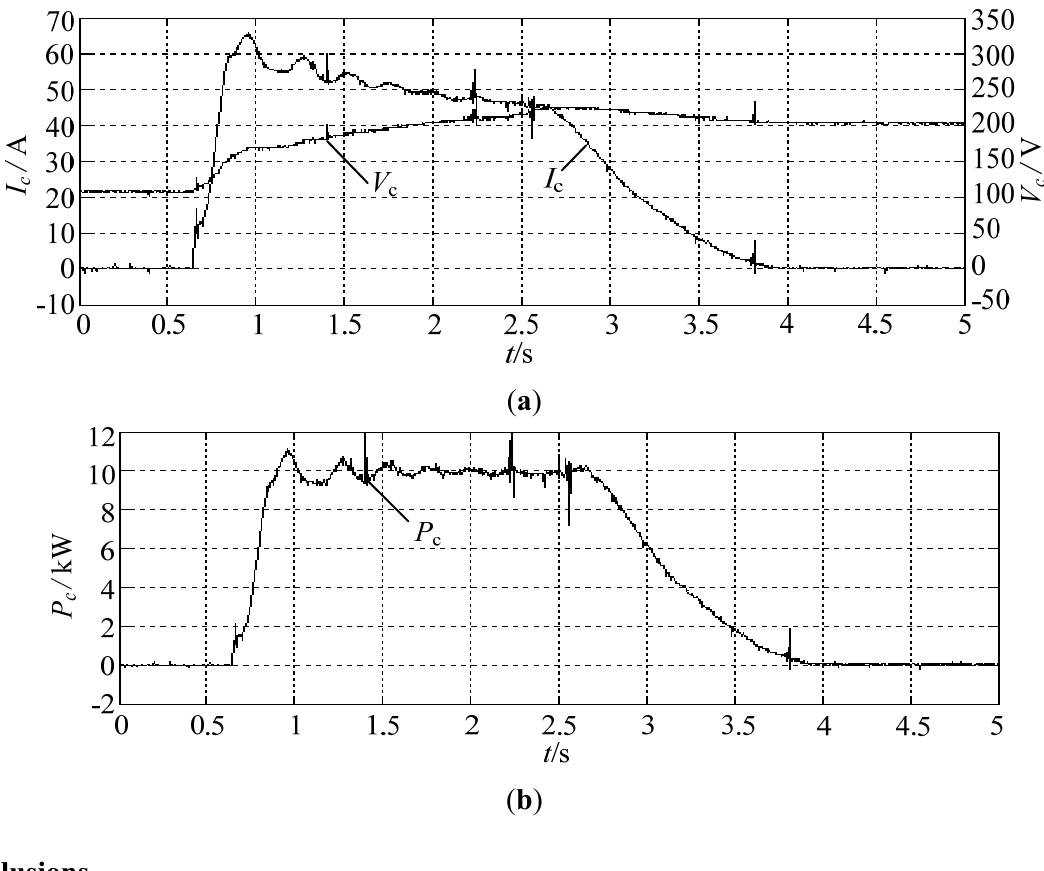
Figure 10. Charging current of the ultra-capacitor pack using H braking. ( a ) Terminal voltage of the ultra-capacitors ( V power of the ultra-capacitors ( P